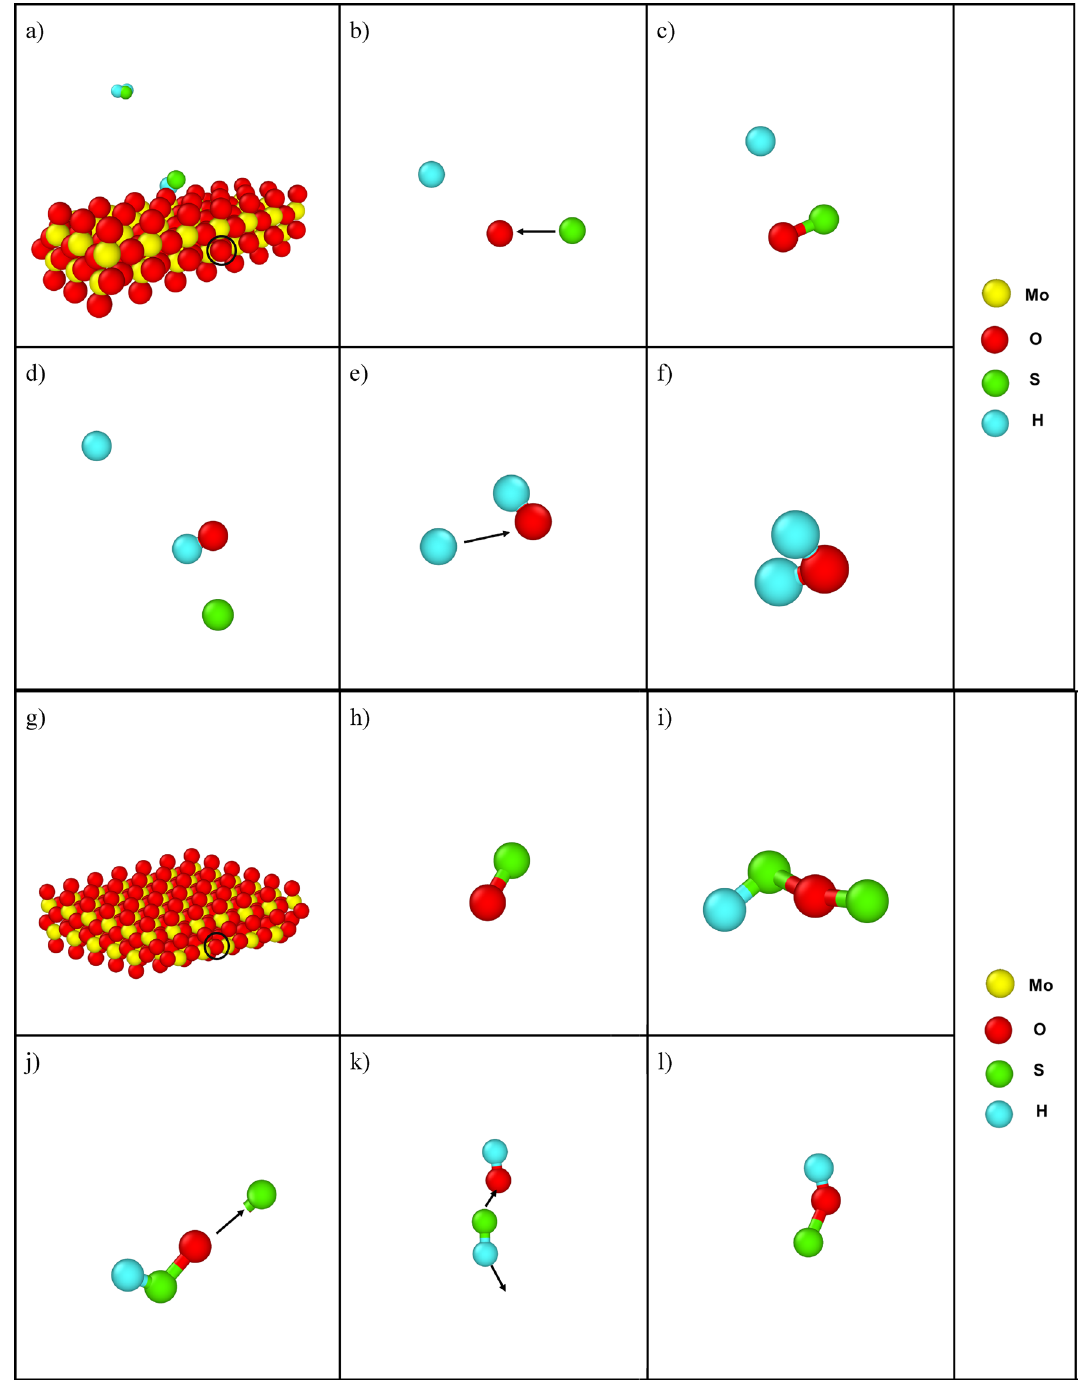
Figure 3. ( a ) MoO 3 cluster of the first oxygen atom. Snapshot of the first oxygen atom at ( b ) 130 ps, ( c ) 150 ps, and ( d ) 225 ps. ( e ) 260 at ( f ) 280 ps g) MoO 3 cluster of the second oxygen atom. Snapshot of the first oxygen atom at ( h ) 55 ps, ( i ) 170 ps, and ( j ) 280 ps. ( k ) 300 at ( l ) 375